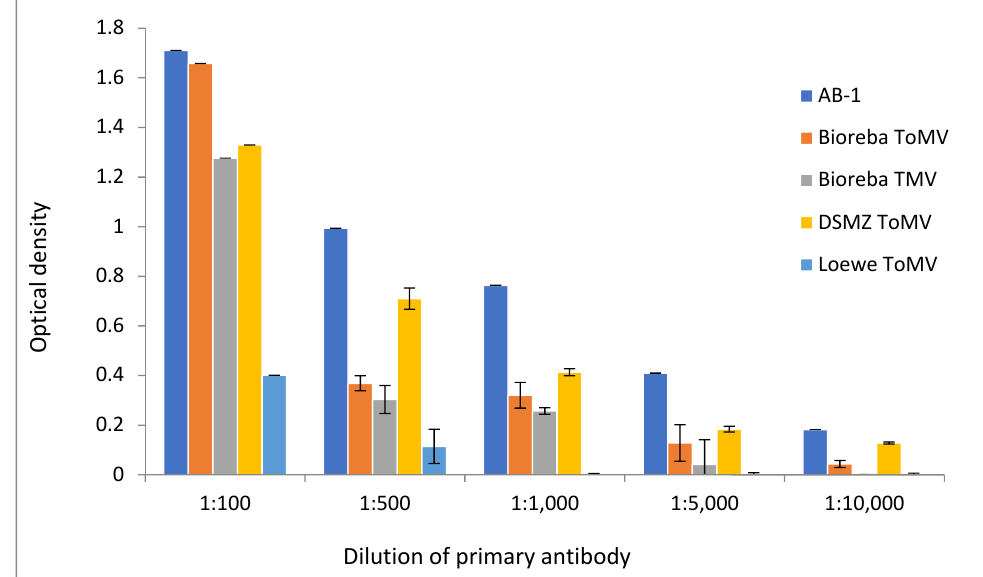
Figure 3. Sensitivity of the differently diluted compared antibodies in ToMV-infected tomato plants by the ELISA assay using five antibodies (new-developed AB-1, three commercial against ToMV— Bioreba ToMV, DSMZ ToMV, Loewe ToMV, and one commercial against TMV—Bioreba TMV) (mean values and standard deviation error bars).